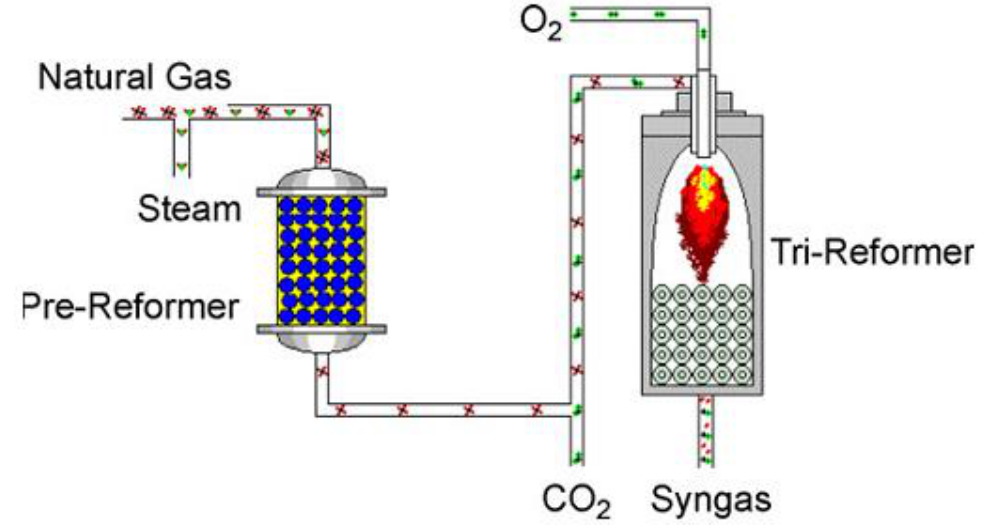
Figure 14. Schematic diagram of KOGAS tri-reforming process, reproduced with permission from [86]. Copyright Elsevier, 2009.